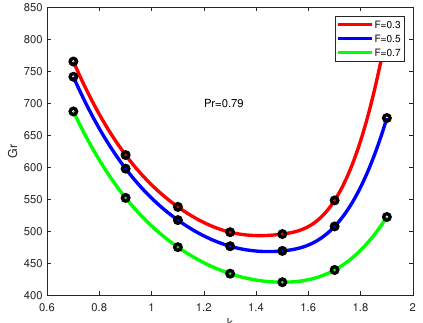
Figure 6. Marginal stability curves for Pr = 0.79 (Case 1).